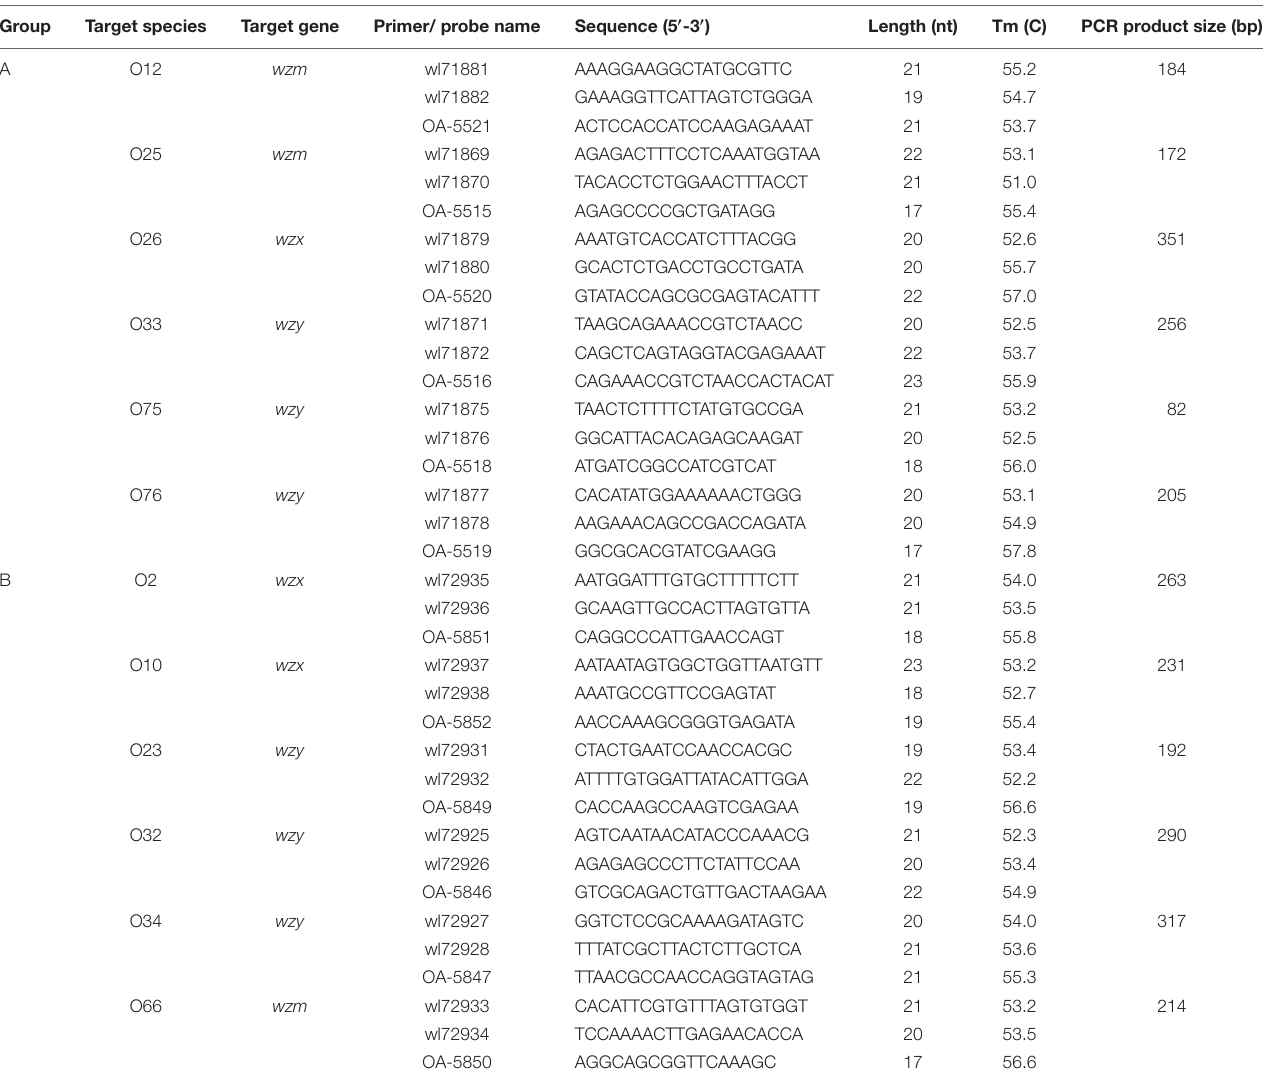
TABLE 2 | Primers and